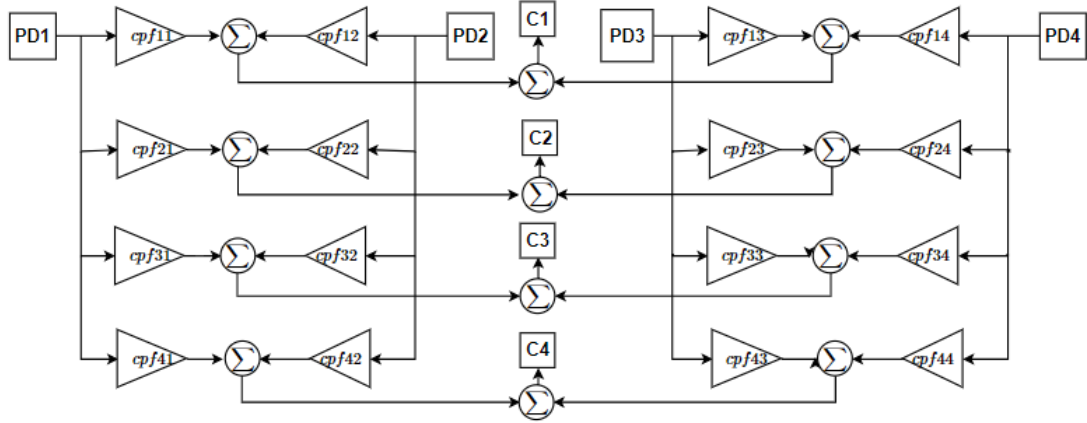
Figure 4. Dynamics of deregulation